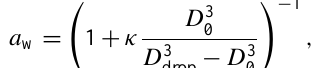
0.52 ± 0.32, 0.37 ± 0.21 and 0.04 ± 0.04 µg m − 3 for